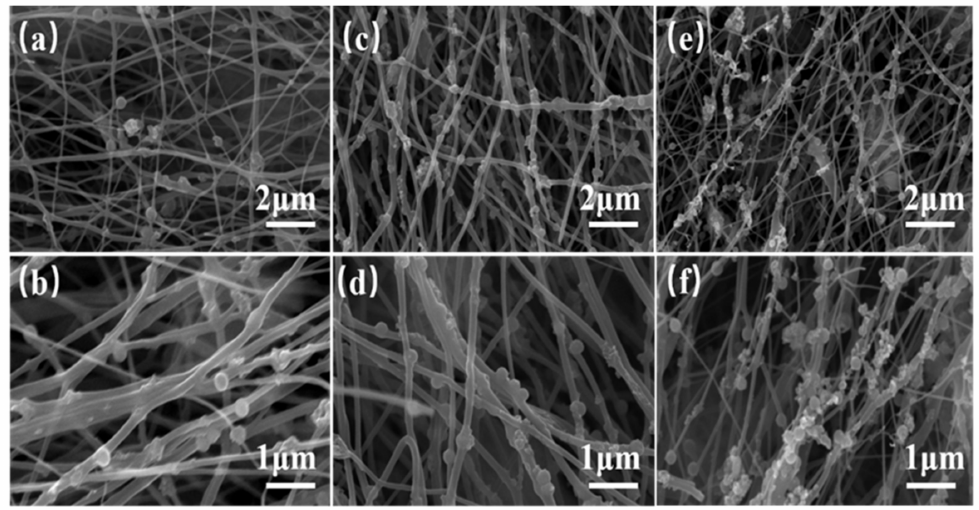
Figure 2. SEM images of ( a , b ) P − Si@CNFs − 100, ( c , d ) 150, and ( e , f )